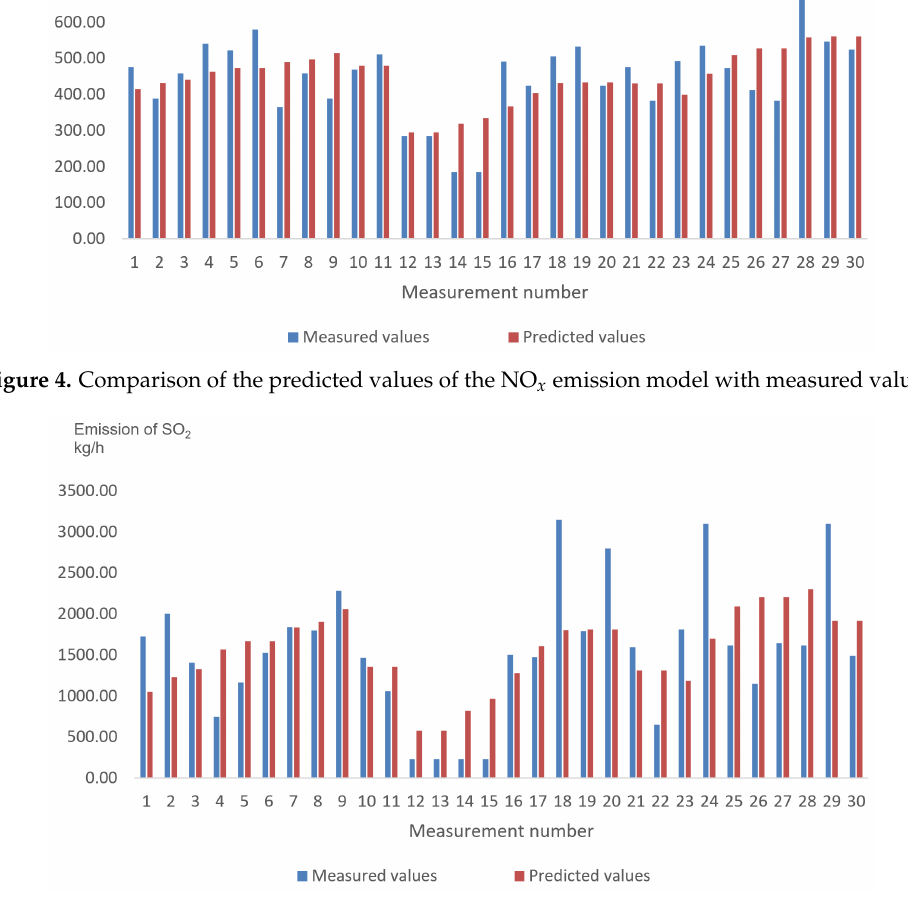
Figure 5. Comparison of the predicted values of the SO 2 emission model with measured